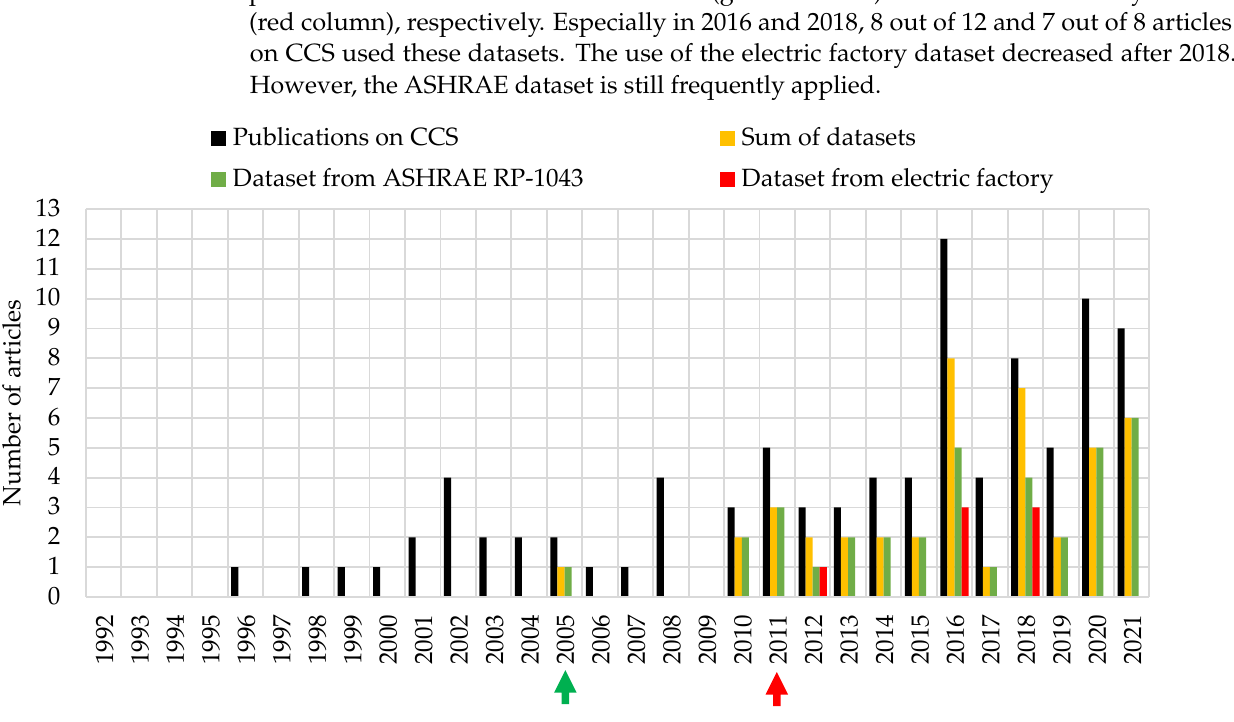
Figure 15. Number of publications on CCS and datasets used. Black: total number of publications on CCS per year. Yellow: the sum of the presented datasets. Green: number of articles on CCS using the ASHRAE RP-1043 dataset. Red: number of articles on CCS using the electric factory dataset. The green and red arrows indicate when the ASHRAE RP-1043 dataset and the electric factory dataset, respectively, became publicly available.